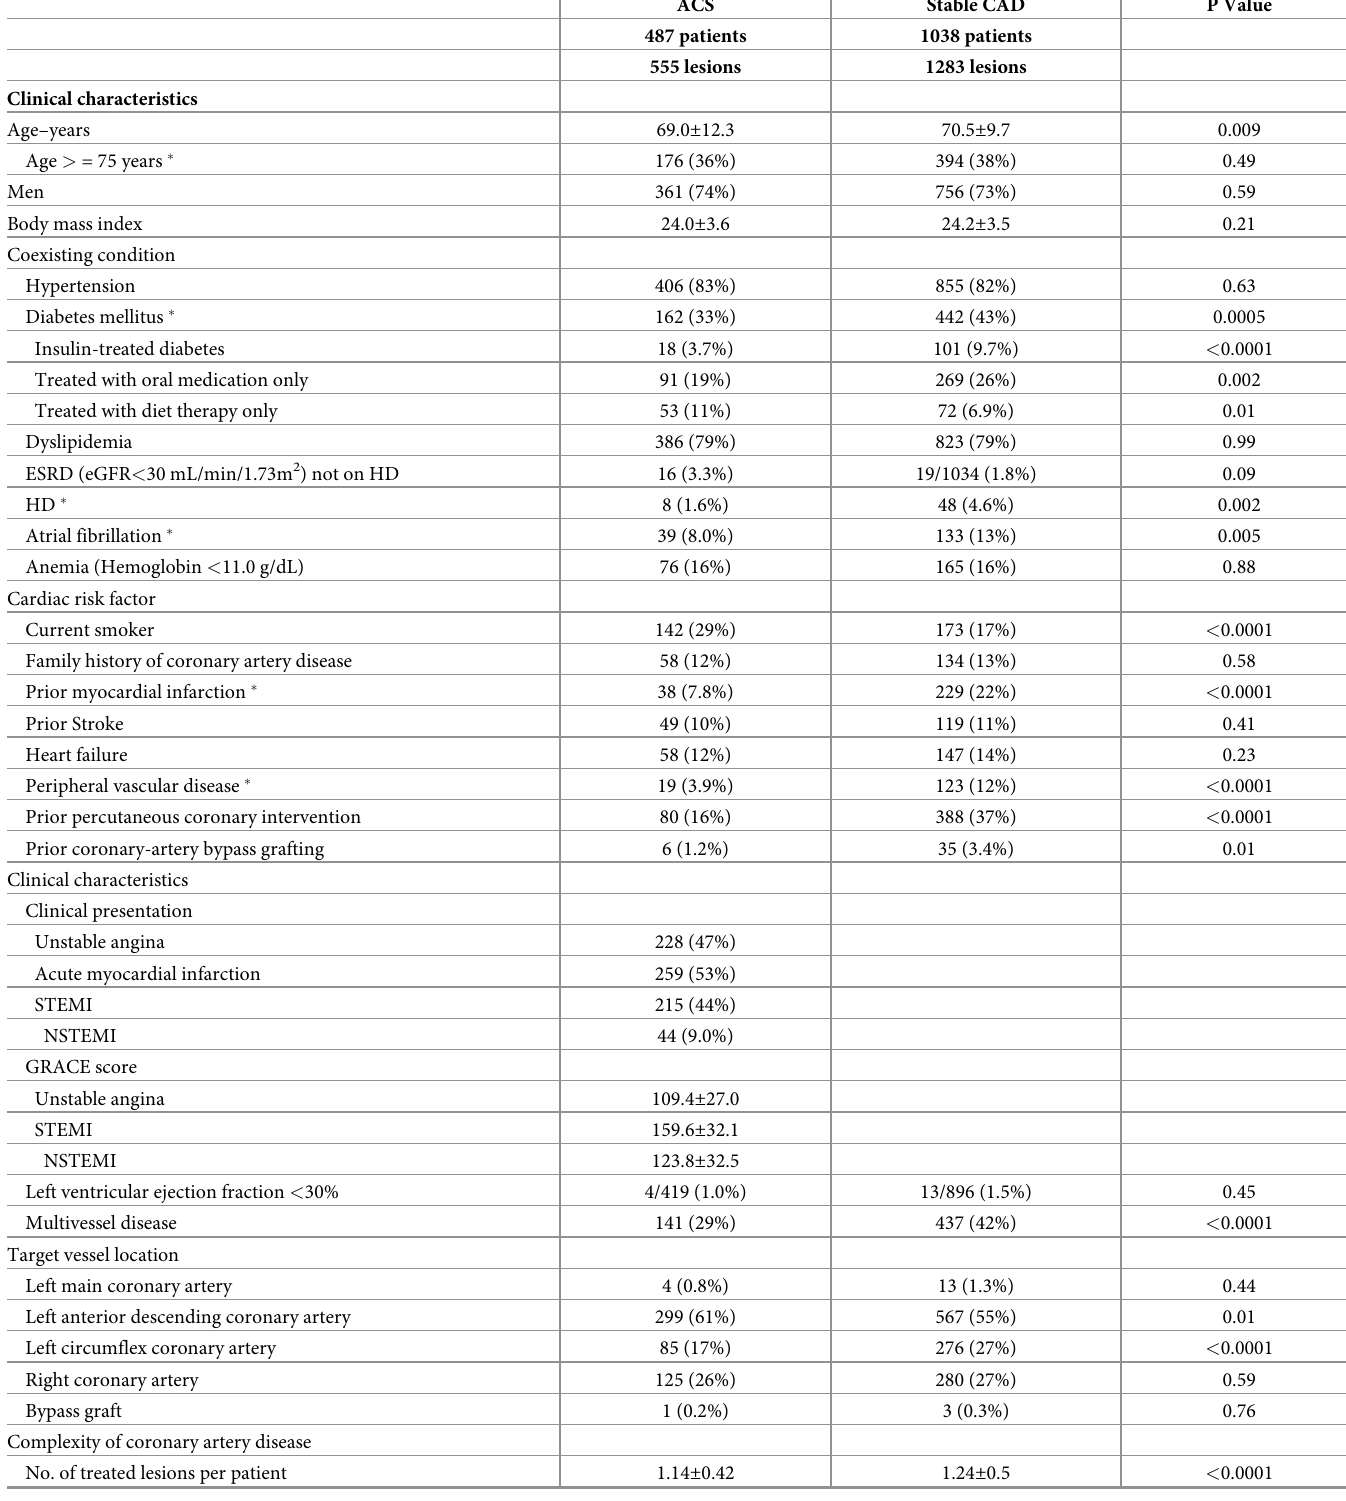
Table 1. Baseline characteristics: ACS versus stable